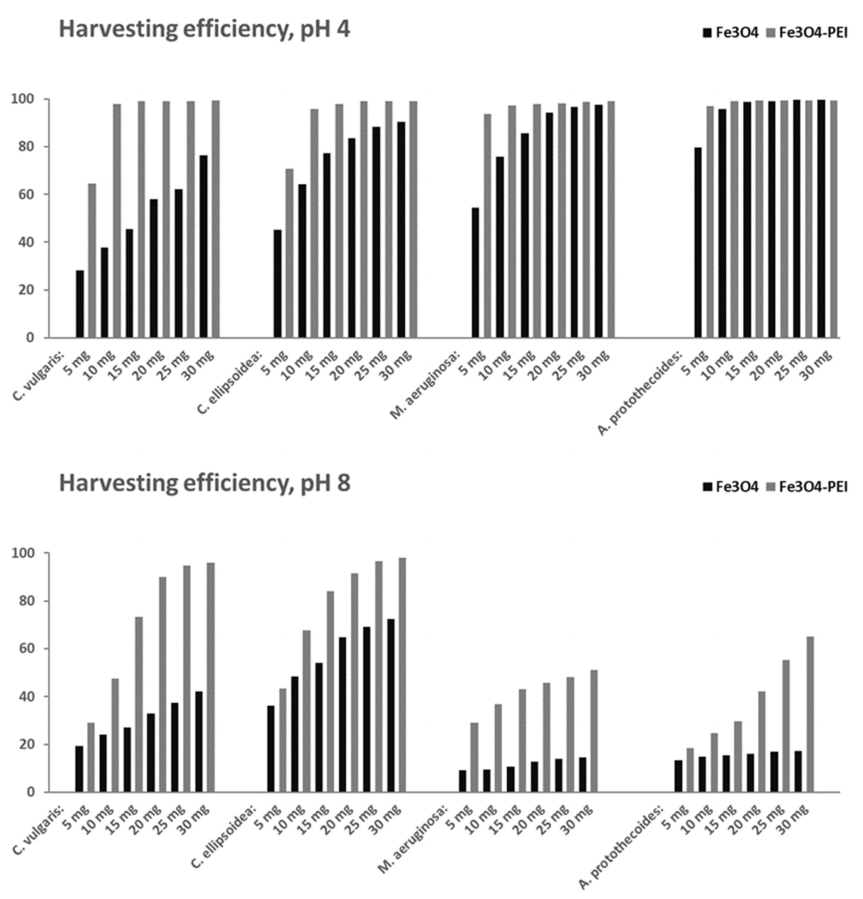
Figure 8. Harvesting efficiencies (in %) of different doses of uncoated and PEI-coated Fe 3 O 4 NPs prepared at 20 ◦ C, at pH 4 ( top ) and 8 ( bottom